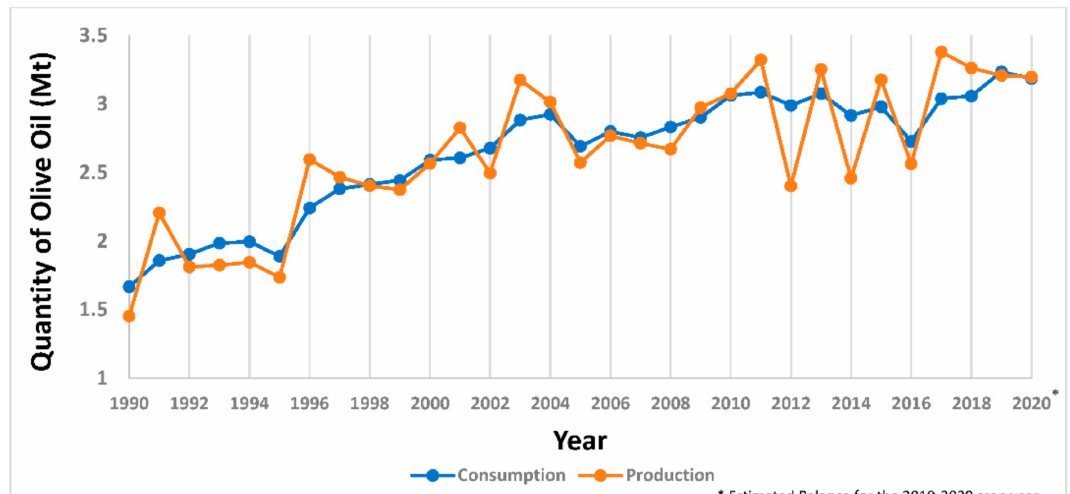
Figure 2. World consumption/production of olive oil—data taken from the site of International Olive Council